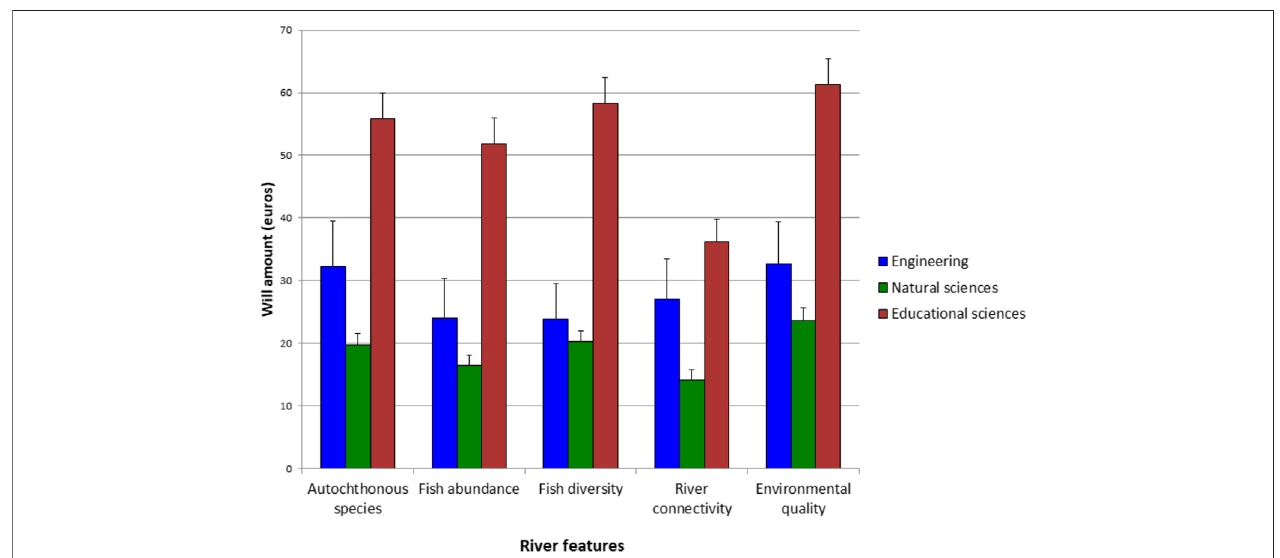
FIGURE 2 | Willingness to pay for conservation of river ecosystem services. Data are presented as the mean number of euros (vertical bars for standard deviation) each group of participants would accept as an increase in their annual taxes for an intervention in river ecosystems.